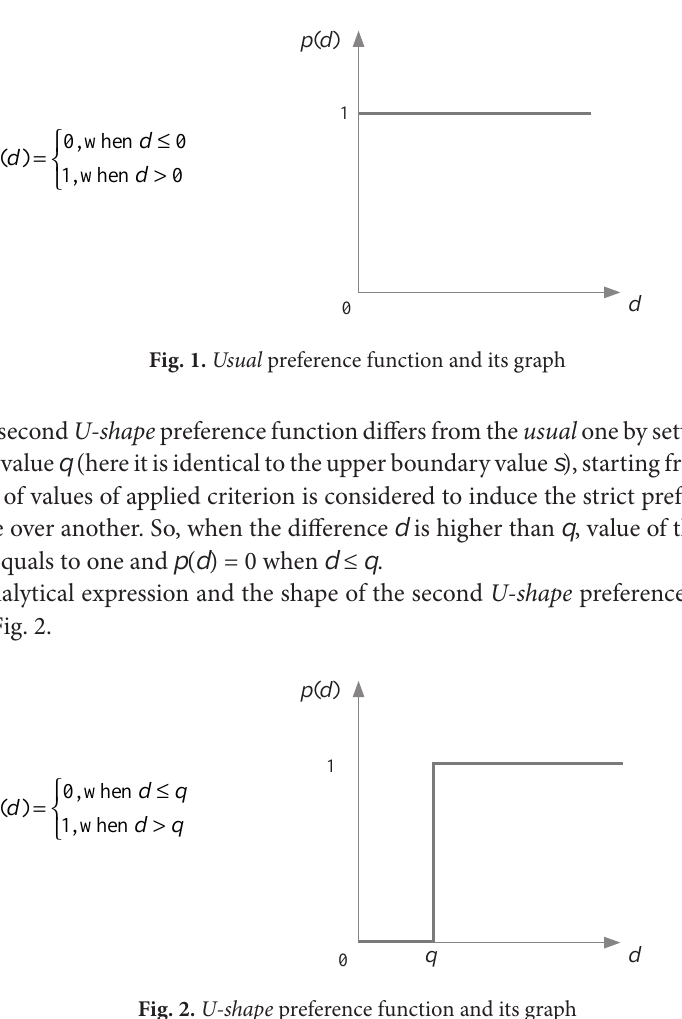
Fig. 2. U-shape preference function and its